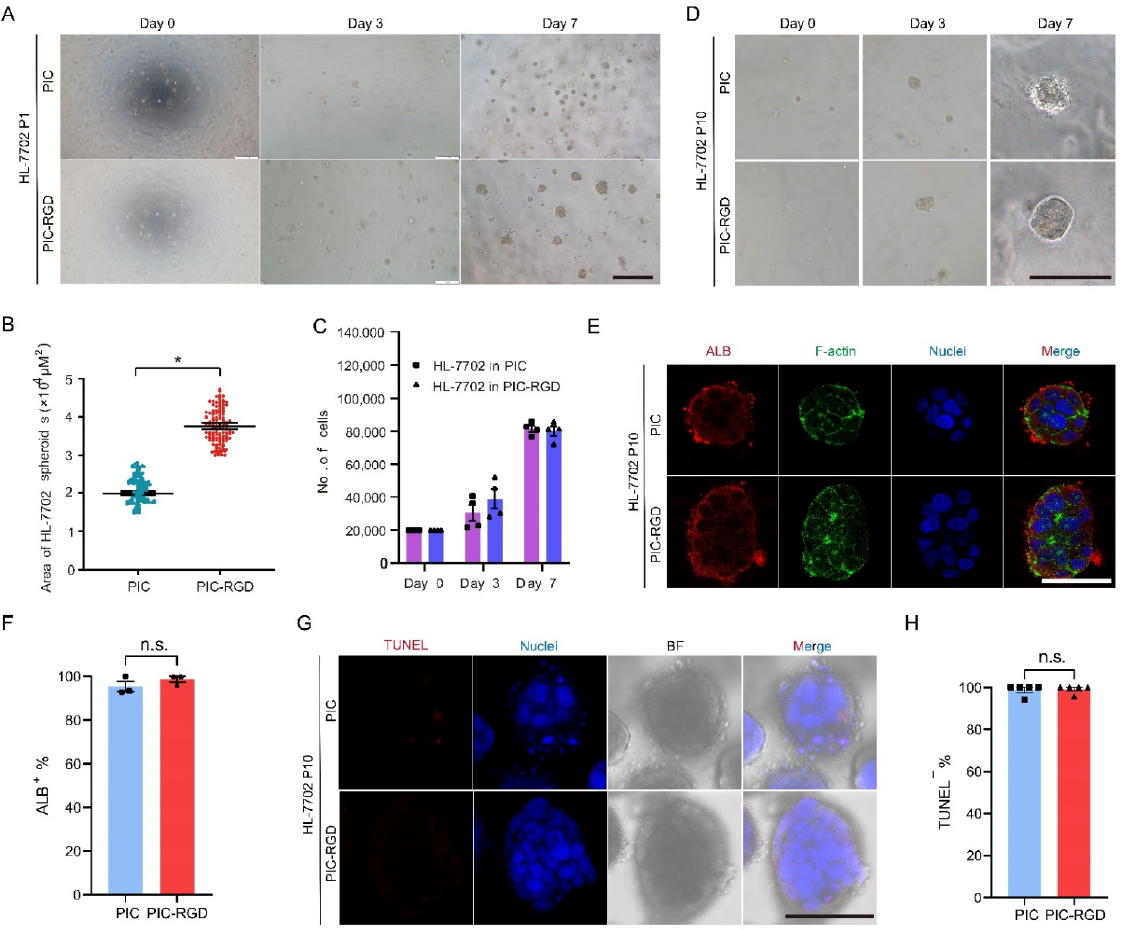
Figure 3. Characterization of HL-7702 in PIC hydrogels. ( A ) HL-7702 cells were encapsulated in PIC and PIC-RGD and went through 7 days of culture (scale bar =400 μ m). ( B ) The maximum projected area of cell spheroids under one field of vision. HL-7702 formed larger spheroids in PIC-RGD than in PIC (* p < 0.05). ( C ) Number of HL-7702 grown in PIC and PIC-RGD for 0, 3, and 7 days. HL-7702 proliferated at a similar rate in PIC and PIC-RGD. The error bars represent the standard error of mean of four experiments. ( D ) The growth characteristic of amplified cells is stable after 10 generations of passaging in PIC and PIC-RGD. Note that HL-7702 were subcultured always in the same type of matrices, either PIC or PIC-RGD (scale bar =200 μ m). ( E ) Fluorescence staining of P10 HL-7702 spheroids after 7 days of culture in PIC and PIC-RGD shows good maintenance of cellular characteristics. ALB: in red, hepatocyte maker; phalloidin: in green, stains F-actin and Hoechst33342: in blue, stains cell nuclei (scale bar =100 μ m). ( F ) Percentage of ALB positive cells per field of vision. ( G ) TUNEL assay (red) with Hoechst33342 staining (blue, cell nuclei) and bright field image of P10 HL-7702 after 7 days in culture in PIC and PIC-RGD show few apoptotic cells in spheroids (scale bar =100 μ m). ( H ) Percentage of TUNEL negative cells per field of vision. For all samples, the PIC and PIC-RGD concentration c = 1 mg mL − 1 and the initial cell density is 200,000 cells mL − 1 . (n.s. means no significant differences).